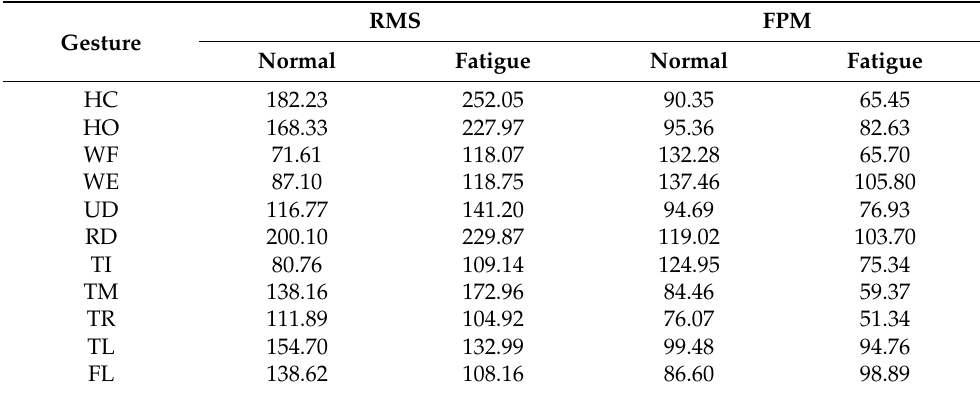
Table 1. Comparison between muscle normal and fatigue of each gesture using RMS and FPM.